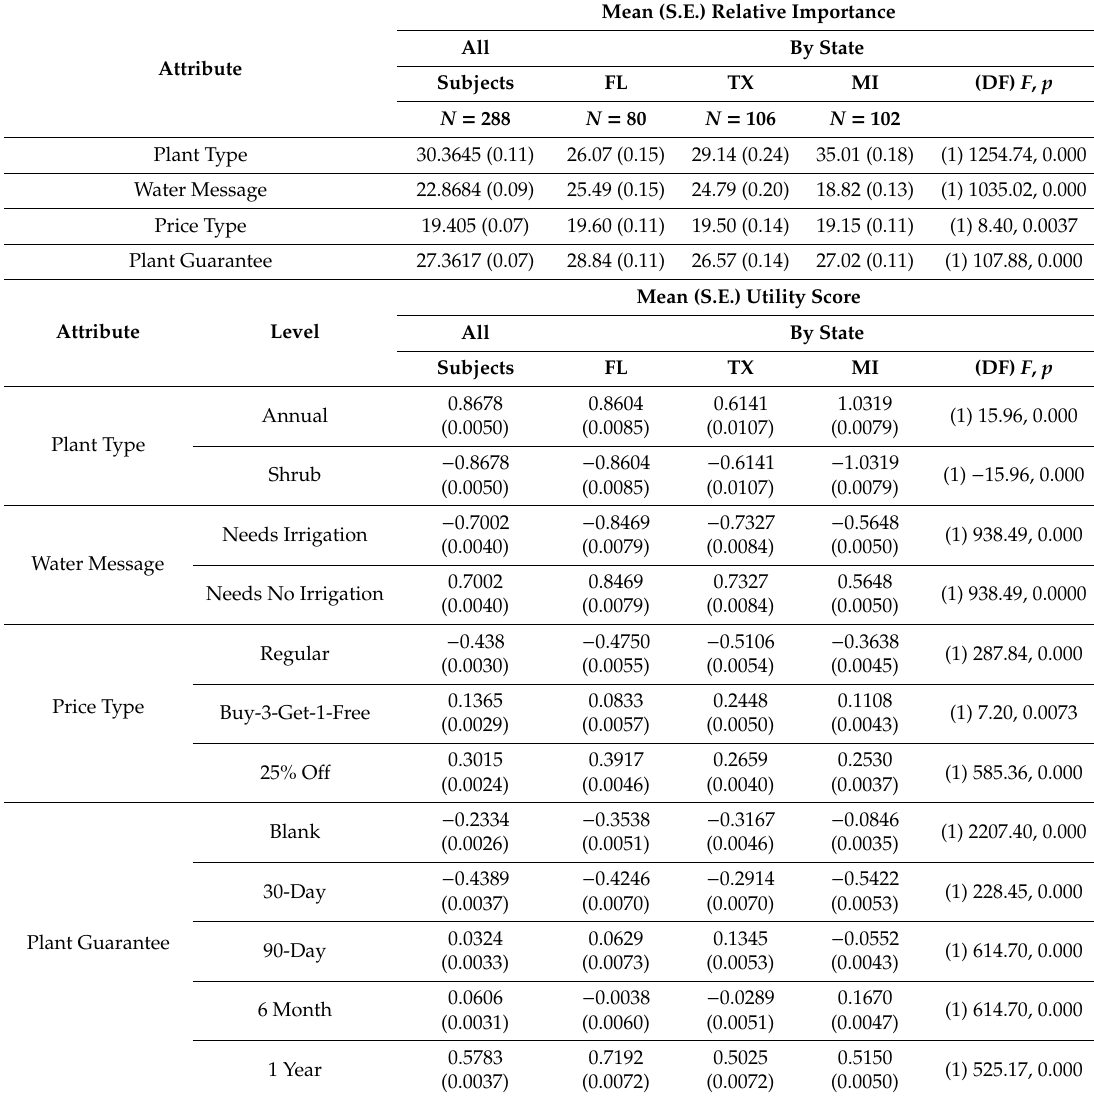
Table 3. Conjoint analysis showing mean relative importance scores and standard errors (S.E.) for each attribute overall and by state 1